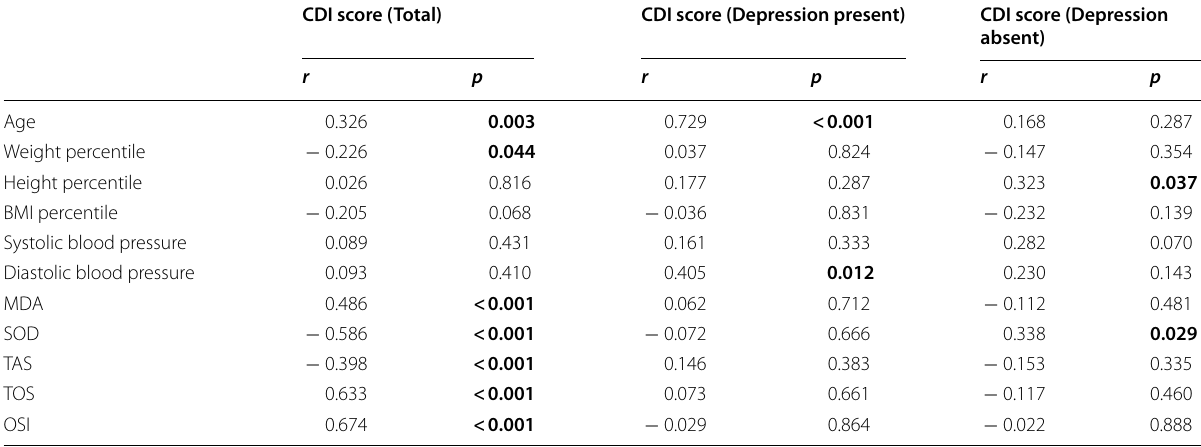
Bold indicates p -value Spearman correlation